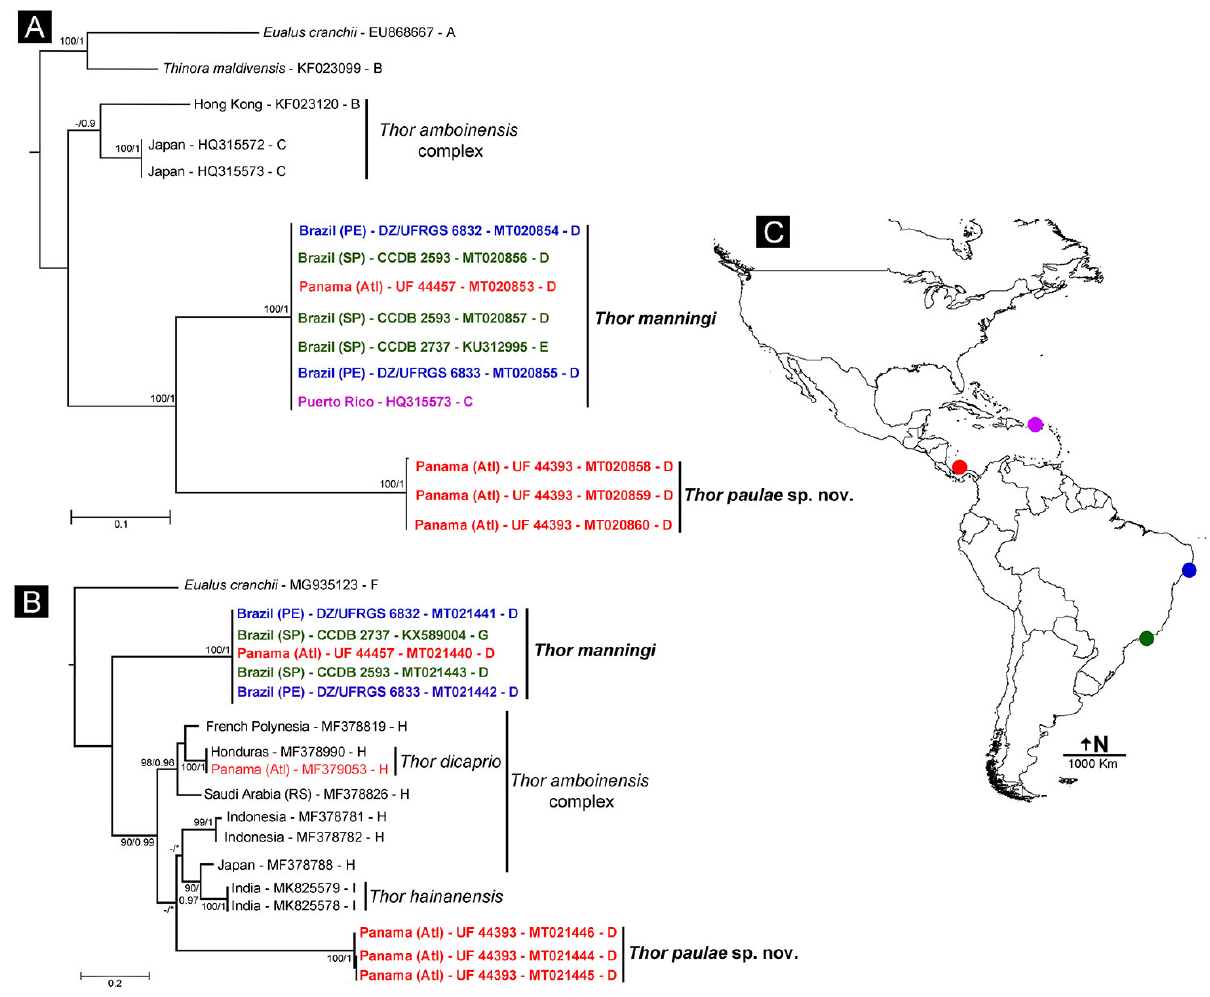
Figure 4. Maximum Likelihood phylogenetic trees based on 16S mt ( A ) and Cytochrome Oxidase subunit I ( B ) genes. Numbers on branches represent bootstraps/posterior probabilities (Maximum Likelihood/Bayesian Inference), numbers < 90 %/0.90 are not shown. Colors correspond to localities in the map ( C ). Localities - Atl: Atlantic; PE: Pernambuco; RS: Red Sea; SP: São Paulo. Collections - CCDB: Coleção de Crustáceos do Departamento de Biologia, Faculdade de Filosofia Ciências e Letras de Ribeirão Preto, Brazil; DZ/UFRGS: Coleção de Crustáceos do Departamento de Zoologia, Universidade Federal do Rio Grande do Sul, Brazil; UF: Florida Museum of Natural History, USA. References - A: Bracken et al. (2009 as Thoralus cranchii ); B: De Grave et al. (2014); C: Fiedler et al. (2010 as Thor cf . manningi ); D: present study; E: Terossi et al. (2018); F: D.K.G. Lundin (unpublished data); G: Terossi et al. (2017); H: Titus et al. (2018); I: Madhavan et al. (2019). Bold represents species analyzed in this study. * Represent nodes in the clades not recovered by one of the analyzes